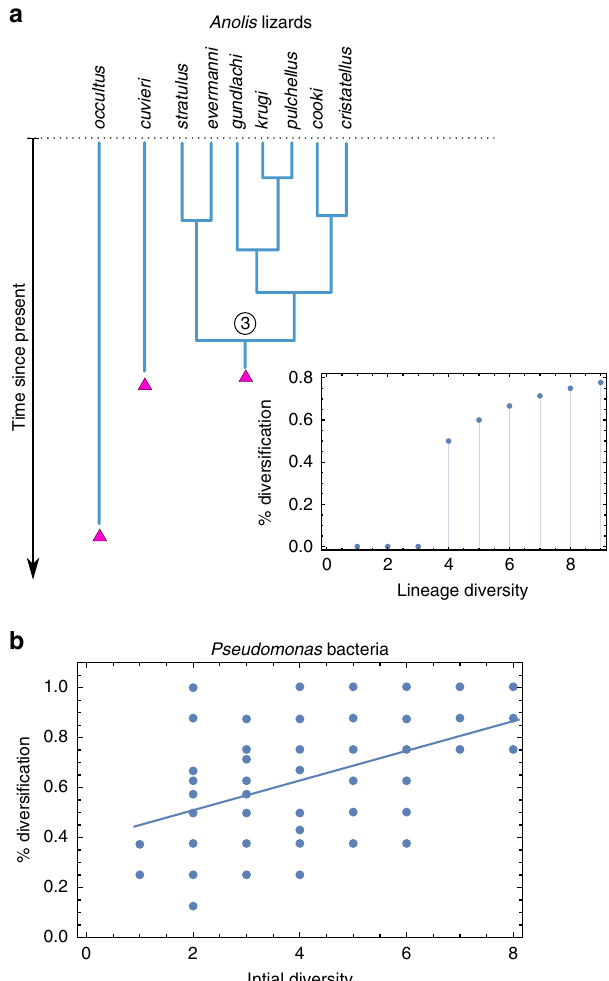
Figure 6 | DDAR can explain patterns at the macro and micro scales. The adaptive radiation of Anolis lizards in Puerto Rico ( a ) presents an initial lag. Under the maximum clade credibility phylogenetic tree 37 , diversification did not start until the third colonization event or possibly, depending on species set and molecular markers, the second 36 (Supplementary Fig. 2). Data from ref. 37. Experimental evolution of the bacteria Pseudomonas fluorescens F113 ( b ) indicates that greater initial diversity (number of strains) promotes evolutionary diversification (fraction of evolved genotypes). The line represents a significant linear regression on diversity ( P ¼ 0.0013). Data from 40 .